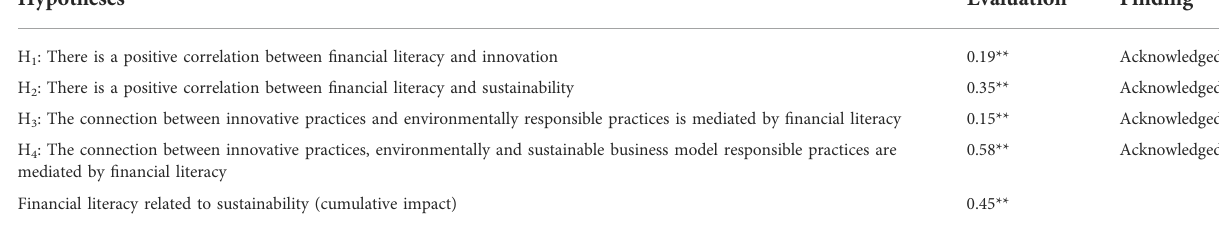
TABLE 7 Hypotheses testing